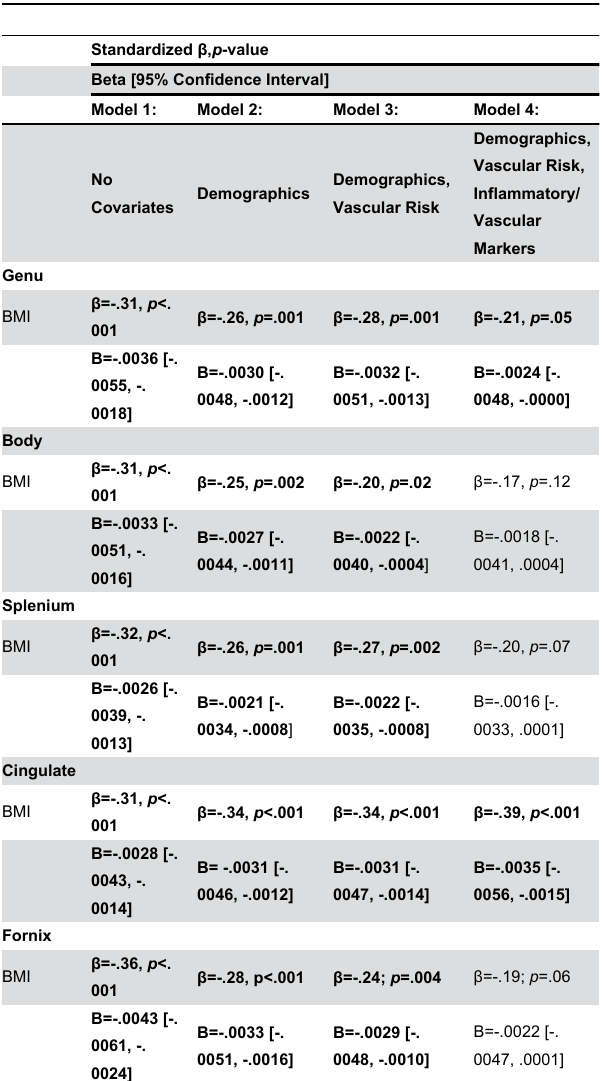
Table 2. BMI Regression Models for Corpus Callosum, Cingulate, and Fornix Fractional